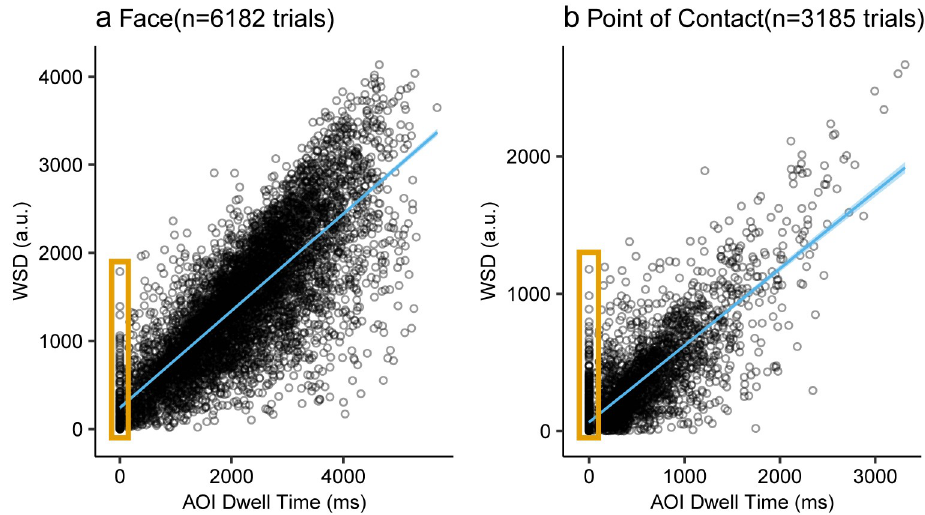
Fig 3. Correlation between AOI dwell time and WSD. a) Correlation between dwell time on face AOIs and face WSDs. b) Correlation between dwell time on point of contact AOIs and point of contact WSDs. The sky blue line denotes the fitted regression line. The shaded region denotes the 95% confidence interval (due to the large number of data points, it is not very visible). Each point denotes a trial. The orange rectangle highlights the trials with zero AOI dwell time. The number of trials for b) is smaller than a) because there are fewer stimuli with point of contact AOIs/ POIs while all stimuli had faces AOIs/POIs.